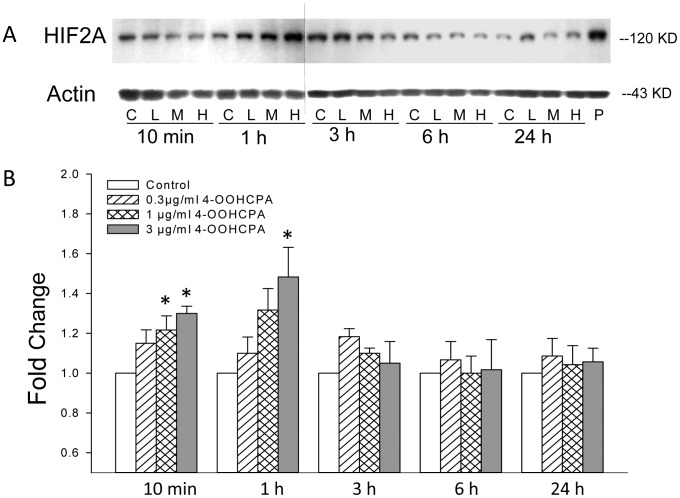
4-OOHCPA exposure induced HIF2A.A: Western blot analysis of HIF2A protein (118KD) and actin (43KD) in limbs at 10 min, 1, 3, 6, and 24 h after treatment with 4-OOHCPA at 0.3 µg/ml (L) 1.0 µg/ml (M) or 3.0 µg/ml (H). P represents the positive control. B: Fold changes from the scan densitometry quantification of the HIF2A band in drug treated groups compared to control groups. Hatched bar: 0.3 µg/ml (L), cross-hatched bar: 1.0 µg/ml (M) and gray bar: 3.0 µg/ml (H). Each bar (mean ± SEM) represents six to seven replicates; bars with an asterisk are significantly different from control at the same time point (p ≤0.05).